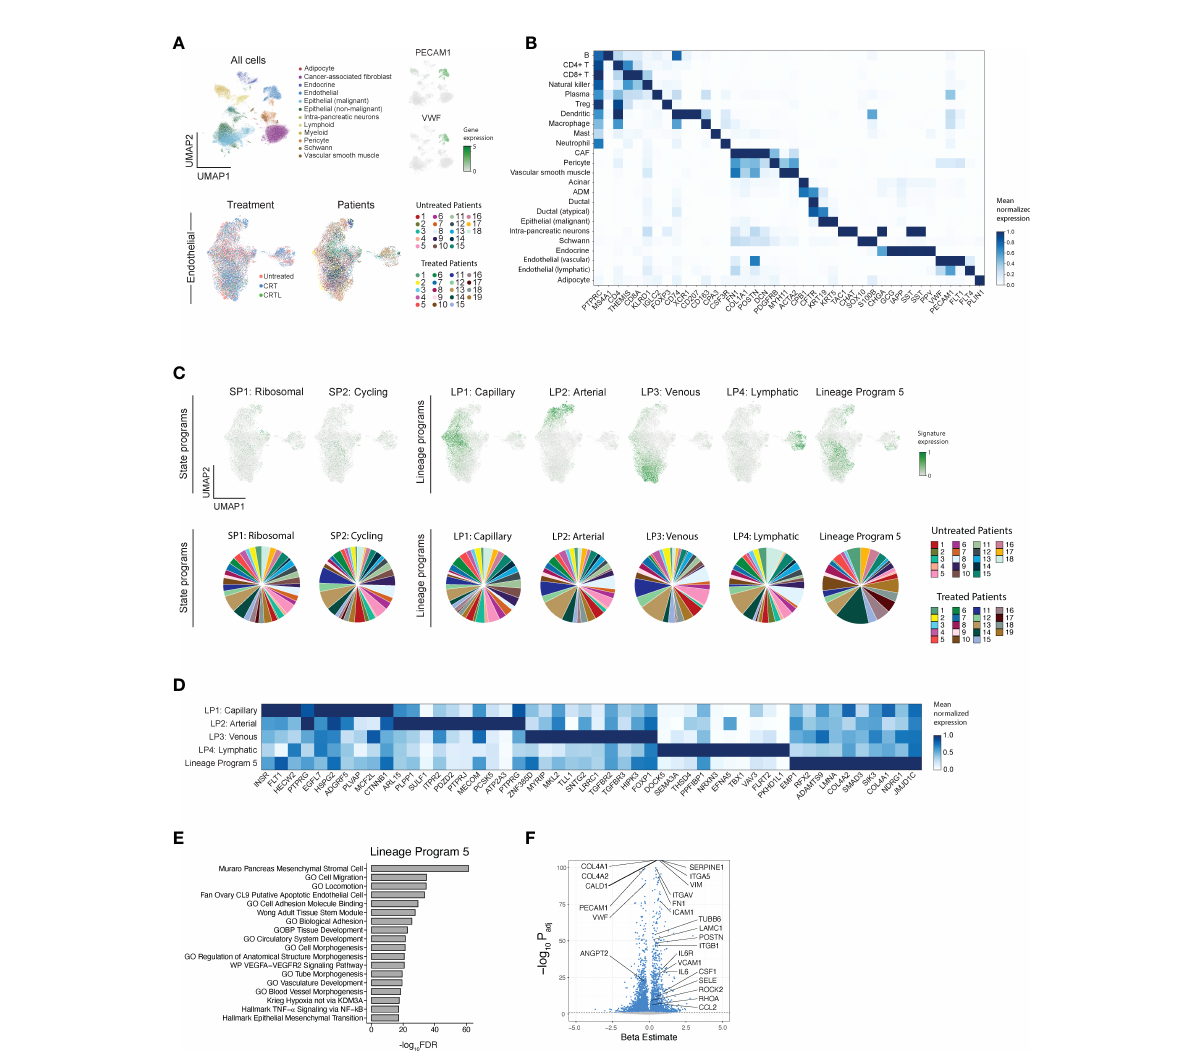
FIGURE 1 Single-nucleus RNA-seq of untreated and treated PDAC specimens captures the diversity of endothelial lineage programs including a reactive endothelial-to-mesenchymal transition (EndMT) program. (A) Single-nucleus RNA-seq captures diverse epithelial, immune, and stromal cell subsets. Top: UMAP embeddings of single-nucleus pro fi les (dots) of cells from all PDAC tumors, colored by annotated cell subsets (left) and general endothelial marker gene expression (right, insets). Bottom: Distinctions between treatment status and patient ID within the endothelial cell compartment. UMAP embeddings of single-nucleus pro fi les of endothelial cells, colored by treatment status (left; untreated, n = 18; CRT, n = 14; CRTL, n = 5) and patient ID (right). (B) Mean expression (color bar) of selected marker genes (columns) across annotated cell subsets (rows) across all PDAC tumors, normalized for each marker gene. (C) Top: UMAP embeddings of single-nucleus pro fi les (dots) of endothelial cells from all PDAC tumors ( n = 37), colored by the normalized expression score of each of two state programs (left) and fi ve lineage programs (right). Bottom: Proportion of nuclei in each of two state programs (left) and fi ve lineage programs (right), colored by patient ID. (D) Mean expression (color bar) of the top 10 genes (columns) that characterize the endothelial lineage programs (rows), normalized for each gene. (E) Gene set enrichment analysis for Lineage Program 5. (F) Differential expression (beta estimate, x-axis; mixed effects model) and its signi fi cance (-log 10 (p adj value), y-axis) for Lineage Program 5 endothelial cells vs . other endothelial cells. Selected enriched (positive beta estimate) and depleted (negative beta estimate) genes are labeled. Bonferroni-adjusted p value <0.05 is indicated with a dashed horizontal line. Genes with a signi fi cant Bonferroni-adjusted p value are colored blue and others are colored gray. SP, State Program; LP, Lineage